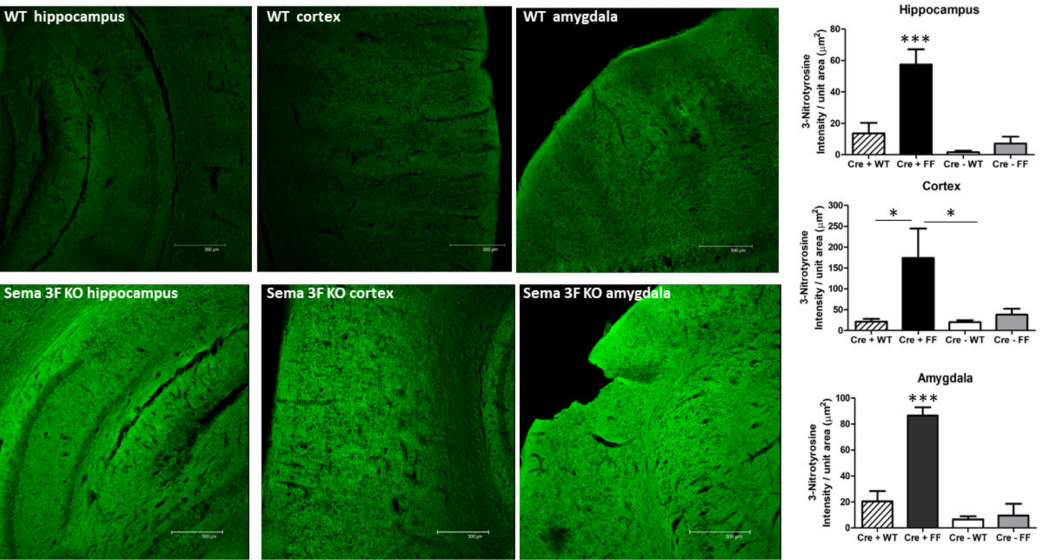
Figure 7. Induction of 3-Nitrotyrosine in Sema 3F KO Mice . Left panel: 3-Nitrotyrosine (3-NT) immunofluorescence in hippocampus, cortex, and amygdala of Sema3F KO mice and their wild type (WT) littermate showed significantly increased 3-NT expression in Sema 3F KO tissue. Right panel: quantification of 3-NT immunofluorescence showed significantly higher fluorescence/unit area in the hippocampus, cortex, and amygdala of Sema 3F KO mice compared to all three control mice; *** p ≤ 0.0001; * p ≤ 0.01; n =